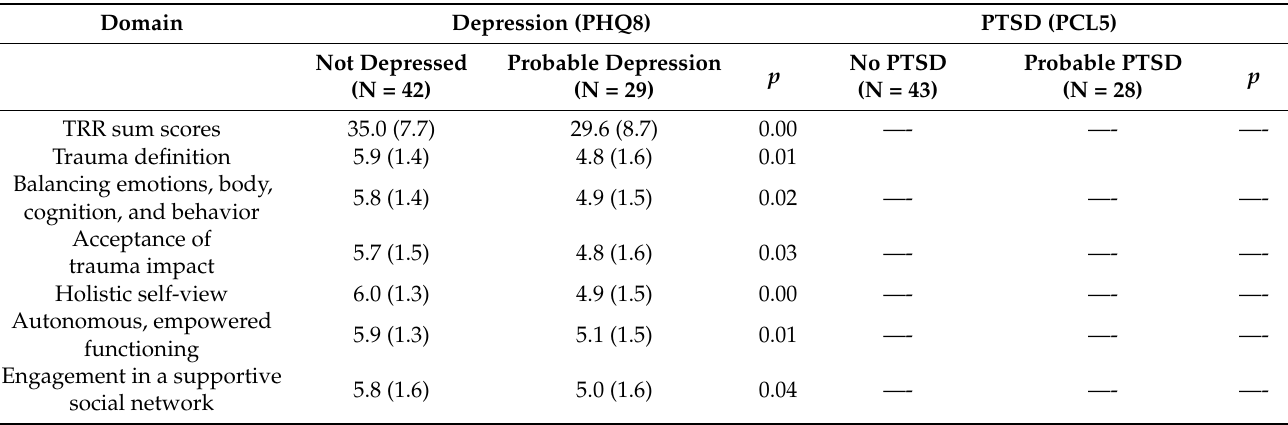
Table 4. Independent sample t -tests of mean TRR sum and domain score by depression and PTSD